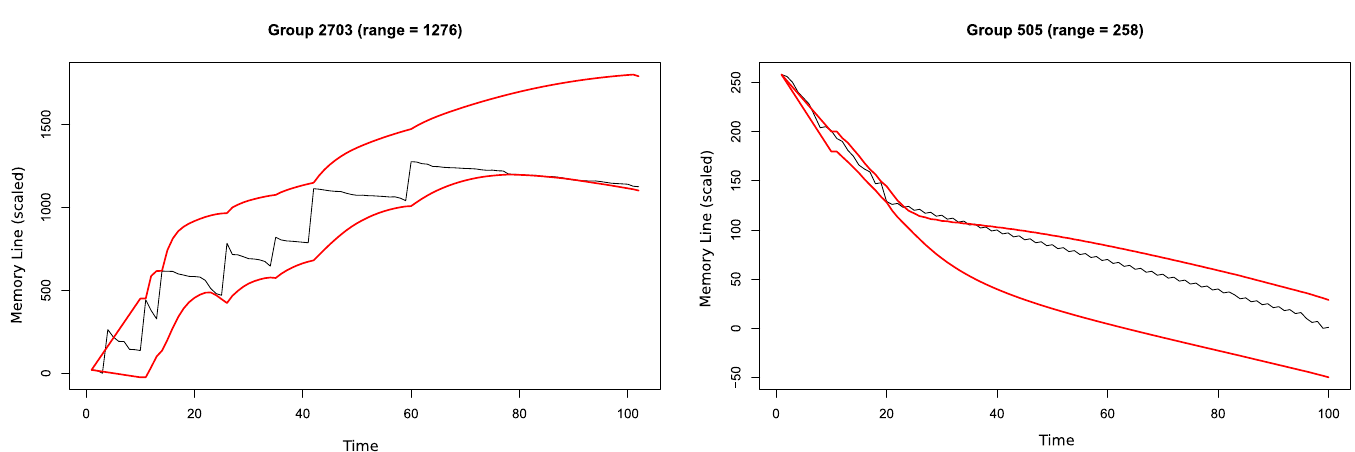
Fig 2. Example of two groups identified by HMM in mcf benchmark. The figures represent the off-chip accessed lines through time and the address interval (red lines) that our prefetcher identify and may use to trigger DRAM C ache prefetches. These groups appear simultaneously and are identified, isolated and grouped by our HMM proposal so prefetches may be individualized to each